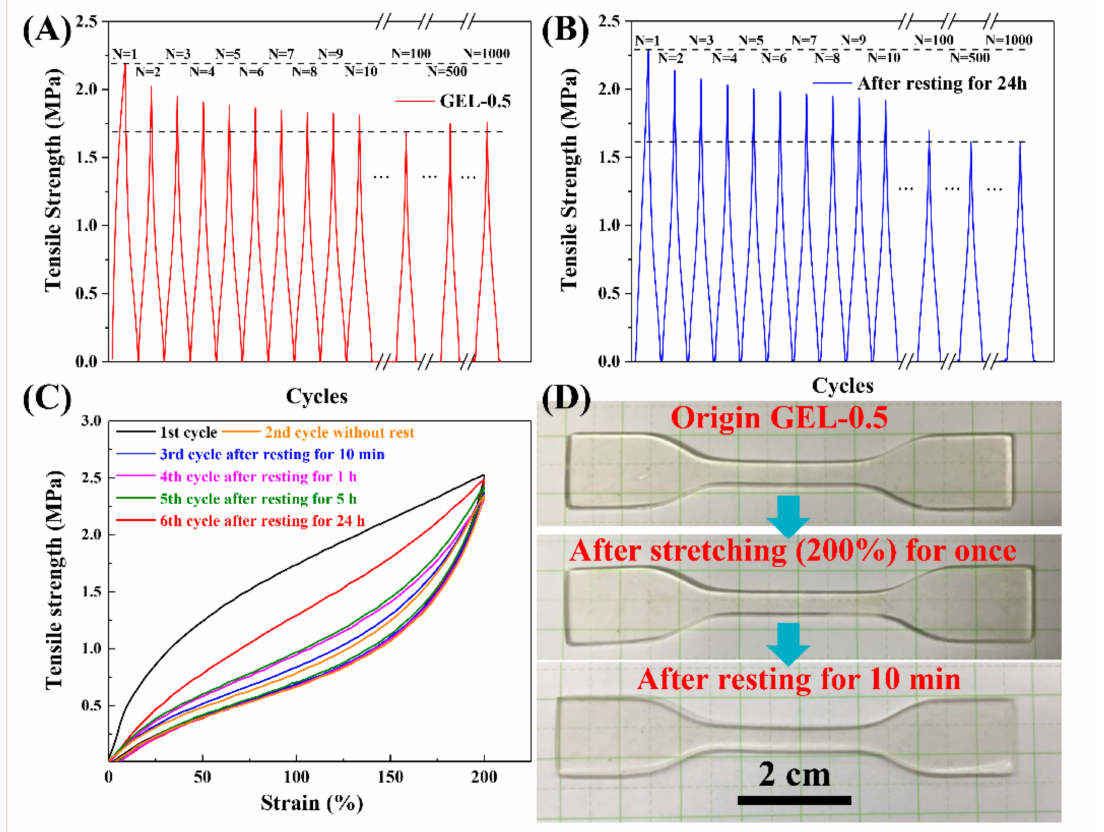
Figure 6. ( A ) Cyclic tensile curves of GEL-0.5 obtained after 1000 tests at a strain of 200%; ( B ) the same operation as ( A ) was performed after GEL-0.5 rested for 24 h; ( C ) cyclic stress–strain curves of GEL-0.5 at a 200% strain with di ff erent rest times; and ( D ) digital photos of GEL-0.5 with fast